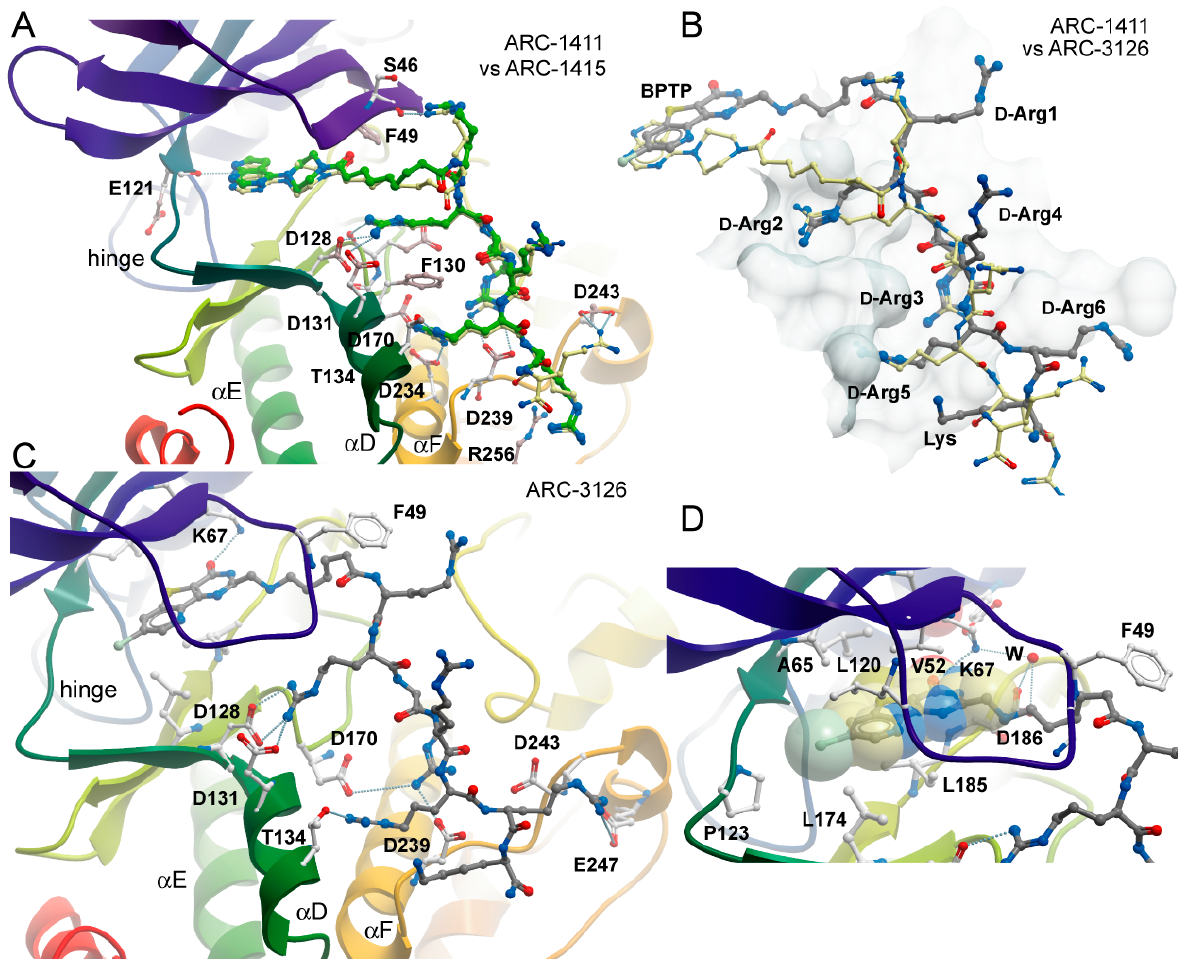
Figure 3. Binding modes of ARC-1415 and ARC-3126. ( A ) Comparison of the binding modes of ARC-1411 and ARC-1415. The figure shows a superimposition of both structures. ARC-1411 carbon atoms are colored in yellow, and ARC-1415 carbon atoms are colored in green. Main interacting residues of PIM-1 are labeled. ( B ) Comparison of the binding modes of ARC-1411 and ARC-3126. Both structures have been superimposed, but for clarity, only the inhibitors are shown on the surface representation of PIM-1. ARC-1411 carbon atoms are colored in yellow and ARC-3126 carbon atoms are colored in gray. The residues in ARC-3126 are labeled. ( C ) Details of the interactions formed by ARC-3126. The main interacting residues are labeled. ARC-3126 carbon atoms are colored in gray. ( D ) Details of the interactions of the ATP-mimetic BPTP moiety and the linker in the ARC-3126 complex. W stands for water molecule.